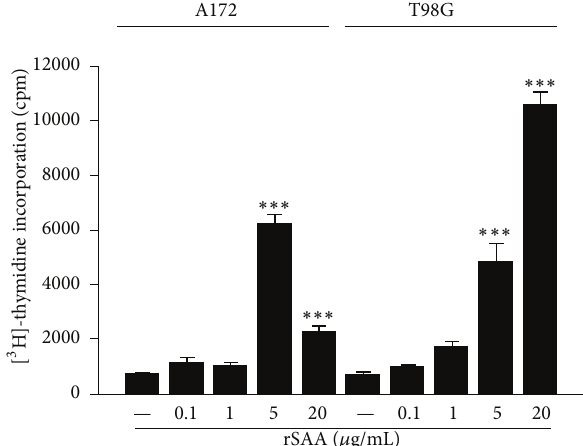
Figure 1: rSAA induces cellular proliferation in glioma cell lines. A172 and T98G cells were treated with increasing concentrations of rSAA (0.1–20 𝜇 g/mL) for 48 h. During treatment, the cells were labeled with [ 3 H-methyl]-thymidine. An increase in the incorpora- tion of [ 3 H-methyl]-thymidine can be observed in the two cell lines when they are treated with higher concentrations of rSAA, showing an increase in cellular proliferation of gliomas. Data represent mean ± SEMofthreeindependentexperiments. ∗∗∗ 𝑃 < 0.001 versus